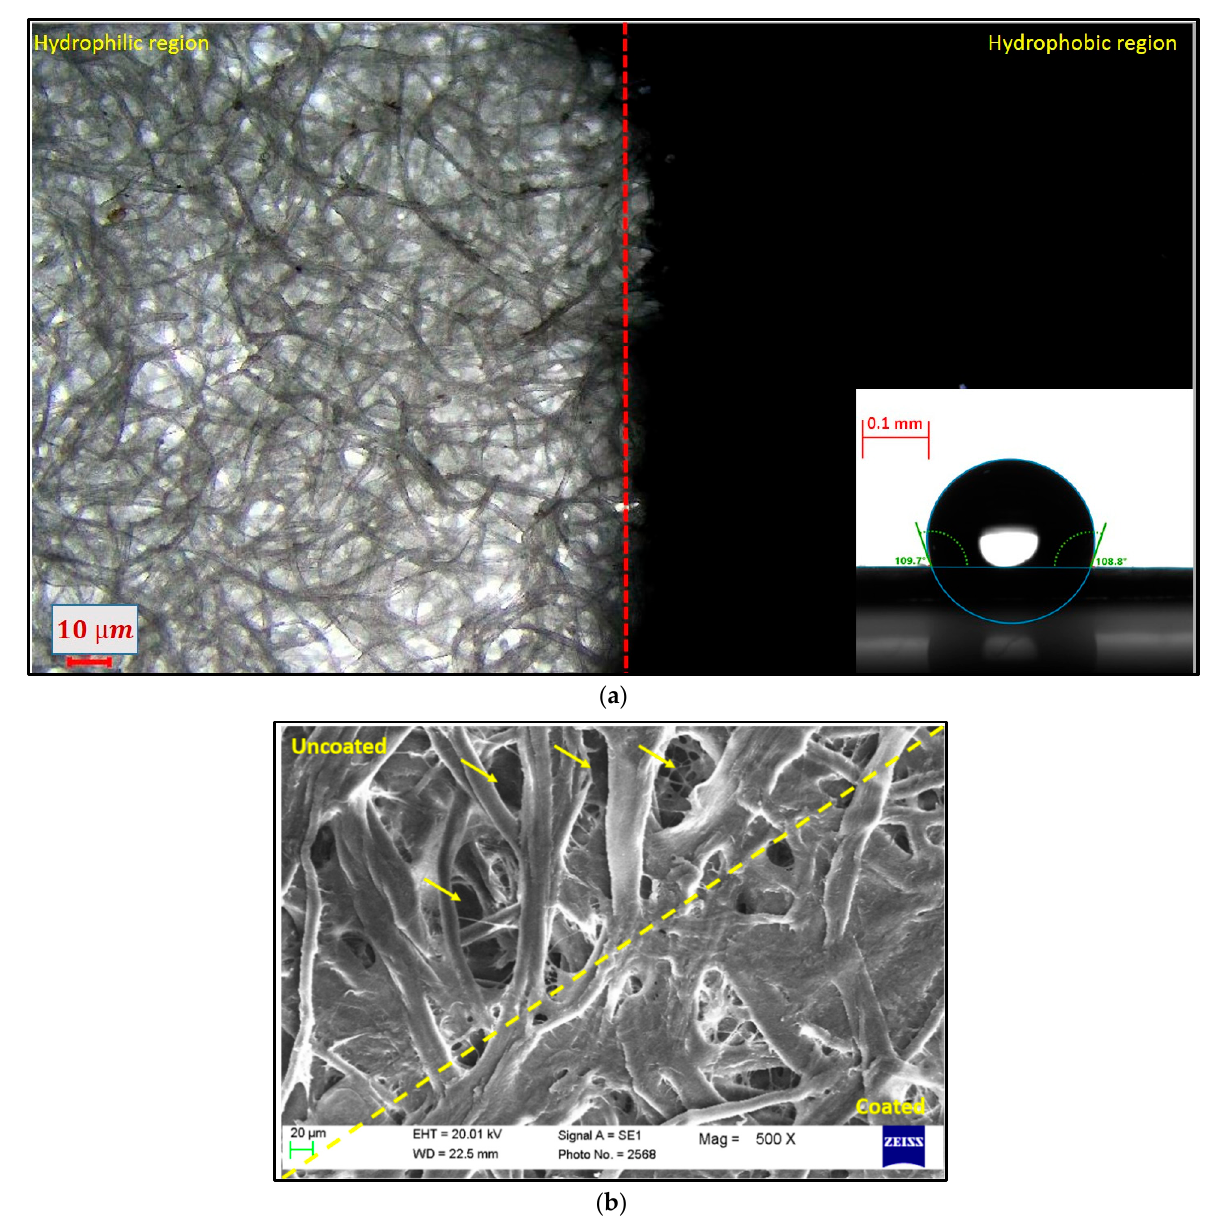
Figure 10. ( a ) Microscopic image of the junction of the unmodified and modified paper (inset contact angle of the modified paper). ( b ). SEM image of the junction of the unmodified and modified paper.